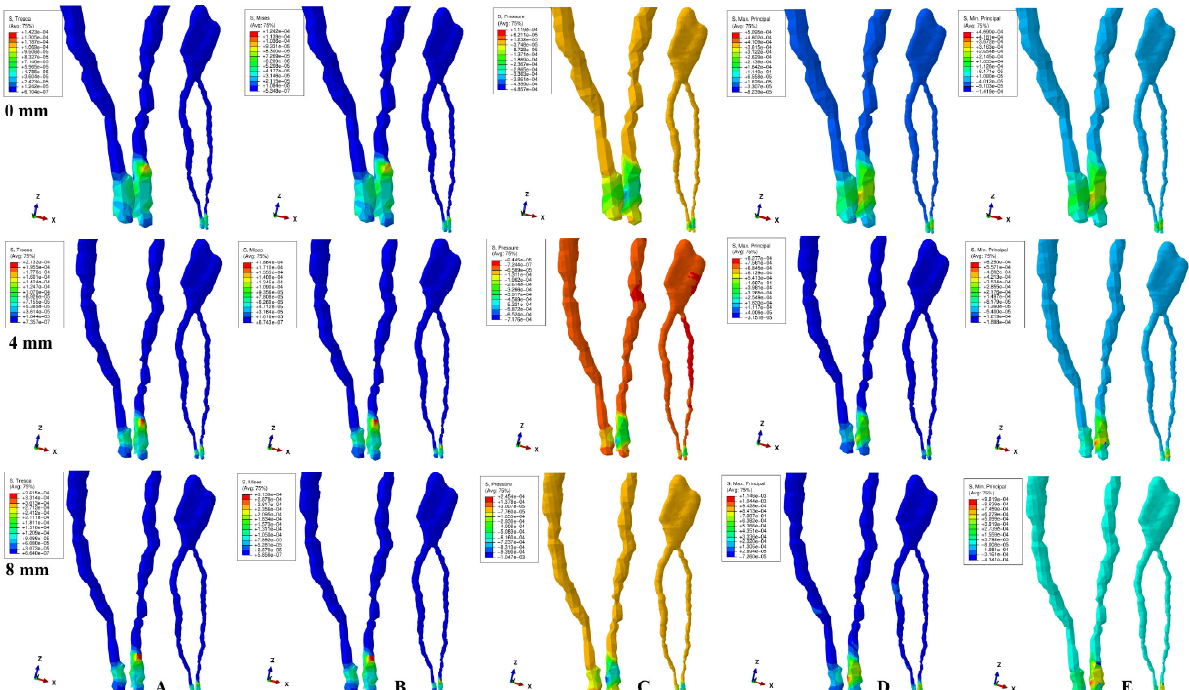
Figure 3. Stress distribution produced by extrusion movement in the apical NVB and dental pulp of one of the nine models (intact, 4 mm and 8 mm reduced periodontium, vestibular-mesial view) in MPa: ( A )—Tresca, ( B )—Von Mises, ( C )—Pressure, ( D )—Maximum principal, ( E )—Minimum